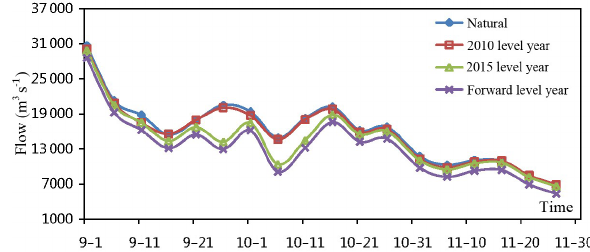
Figure 4. Process of mean flow of Yichang hydrological station from September to November in different level years and the natural condition.